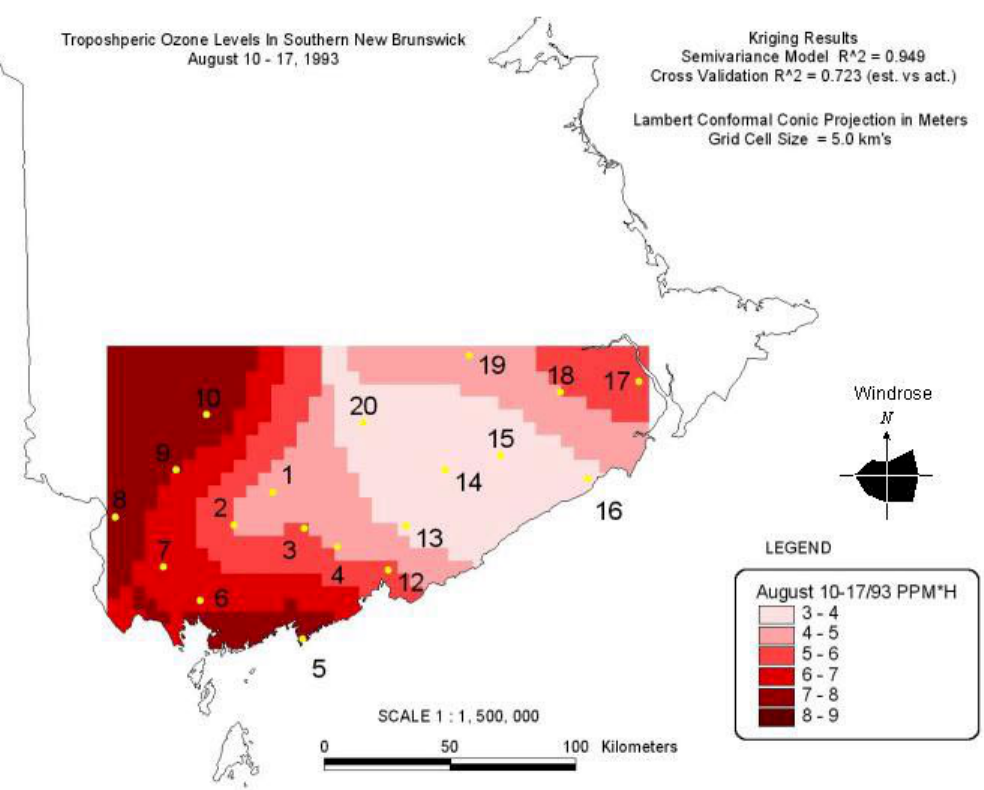
FIGURE 8. Kriged surface of ozone exposures measured with CanOxy Plate passive samplers placed on utility poles in southern New Brunswick. shots” of the ozone climate in rural southern New Brunswick, for determination of potential sites for rural monitoring. The ozone exposures (ppmh) were computed using a calibration line slope derived from samplers colocated at air quality monitors (Blissville, Point Lepreau, and Fundy National Park), and accumulated hourly means from the instrumental monitors over the sampling period. Mean values from the two plates within in the sampler were